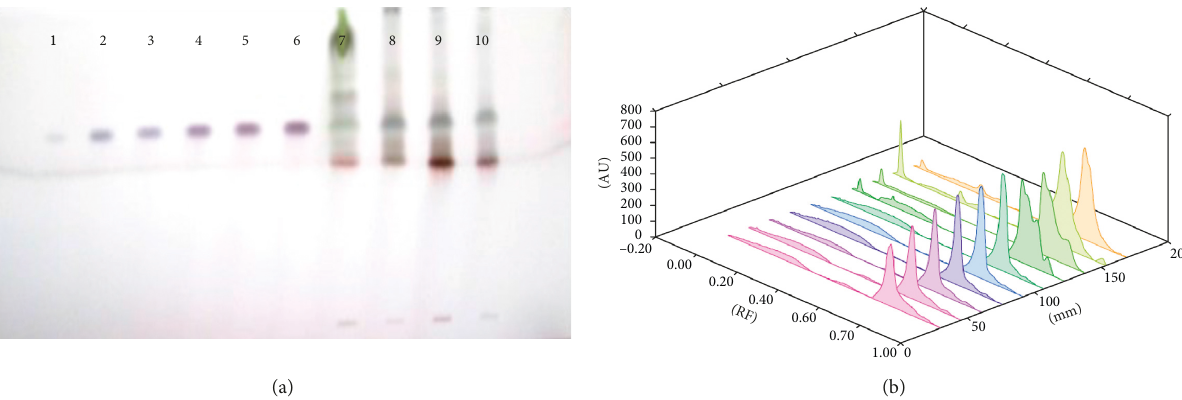
Figure 6: (a) HPTLC fingerprint profile of ergosterol (tracks 1–6) in fruit (track 7); leaf (track 8); stem (track 9); and root (track 10) of S. xanthocarpum ; (b) 3D view of densitogram at